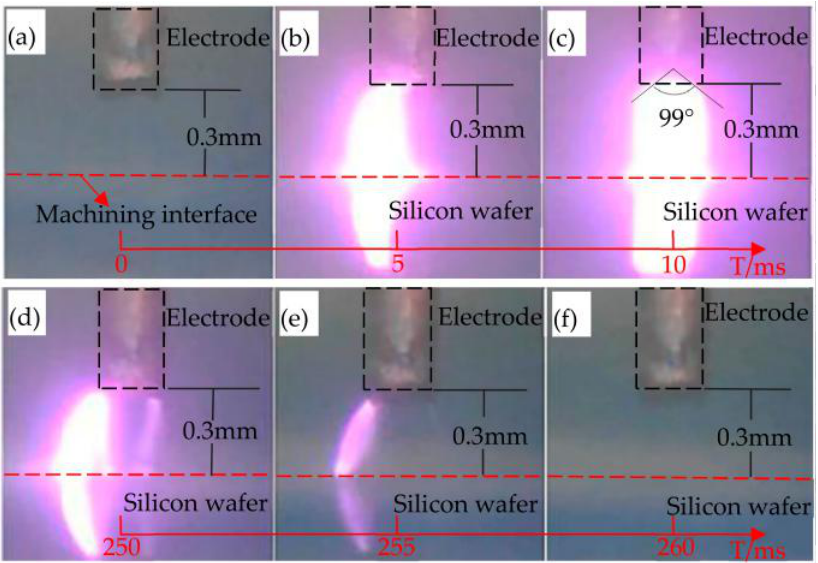
Figure 2. The discharge process of HV ( a ) before discharge, ( b ) discharge begins, ( c ) discharging, ( d ) arc weaken, ( e ) arc is gradually extinguished, and ( f ) end of